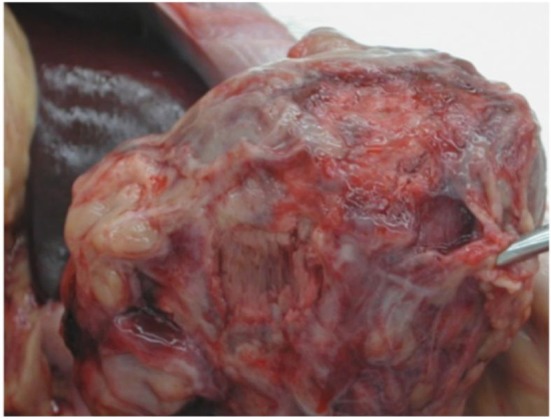
Formation of adhesions. Dense, diffuse intestinal adhesions apparent surrounding graft.